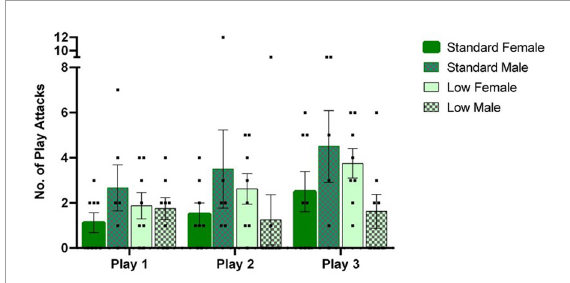
FIGURE4 Play behavior task. Play behaviors including rough and tumble play attacks were assessed during a 1-h time window, following a 3-h isolation period. Following a two-way mixed repeated ANOVA, a significant interaction between sex and resources ( p = 0.04) was observed as well as an effect of time across play sessions ( p = 0.02). Across, all play sessions, post hoc tests revealed that the SR males exhibited a greater number of play attacks than the LR males ( p = 0.04), with the opposite effect observed in the females ( p = 0.05). Individual data points overlap bars representing means ± SEM. Standard resource subjects are shown in solid bars, and low resource subjects are shown in patterned bar ( n = 8 for SR Females, SR Males, and LR females; n = 6 for LR